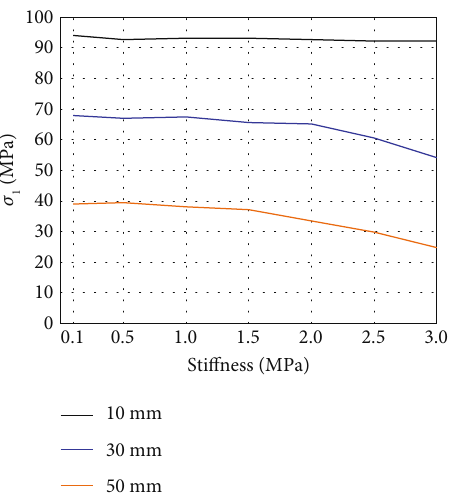
Figure 8: Uniaxial compressive strength of limestone grouting reinforcement bodies under di ff erent crack lengths and di ff erent sti ff ness values of grouting stone bodies.